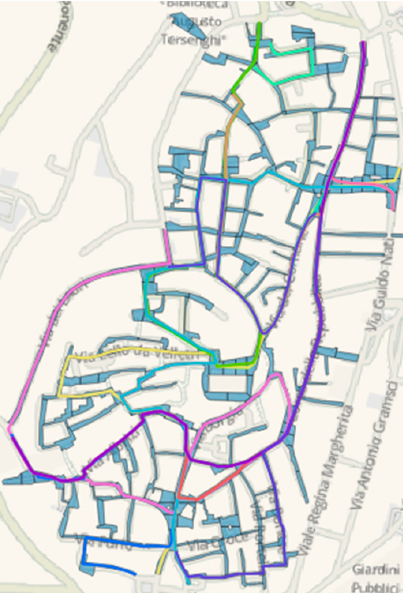
Figure 15. Inspection routes.